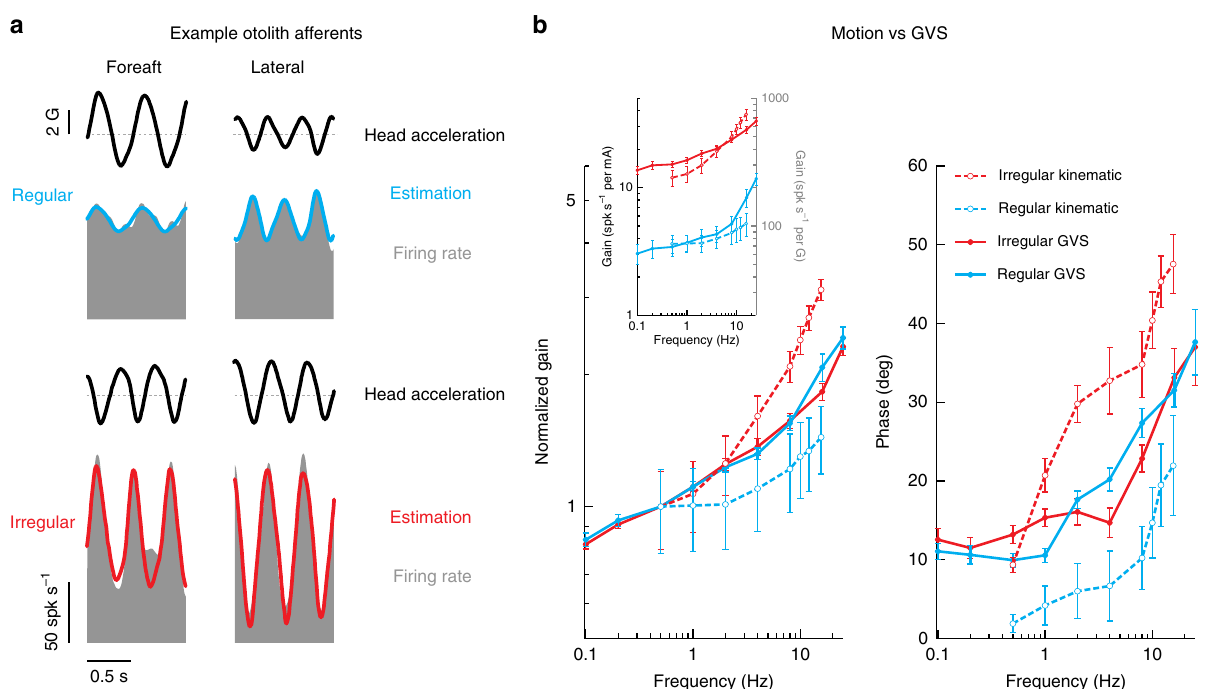
Fig. 5 Comparison of motion and GVS for otolith afferents. a Firing rate (gray) of example regular (blue) and irregular (red) otolith afferents to ~2 Hz foreaft (left) and lateral (right) head acceleration. Firing rate estimates (solid blue and red line) are found using Eq. 5. The irregular otolith afferent was more sensitive to translation than the regular otolith afferent (2 Hz: 223.4 ± 31.2 spk s − 1 per G versus 68.6 ± 17.3 spk s − 1 per G). b Population-averaged neuronal gain (i.e., sensitivity) (left) and phase (right) for regular (blue) and irregular (red) otolith afferents as a function of the translation (dashed lines, from Jamali et al. 46 ) and GVS (solid lines) stimulus frequency. Gain in the main plot was normalized to responses at 0.5 Hz for comparison of responses across stimulus type, while the inset shows the non-normalized gain plotted with stimulus speci fi c units. Error bars depict the